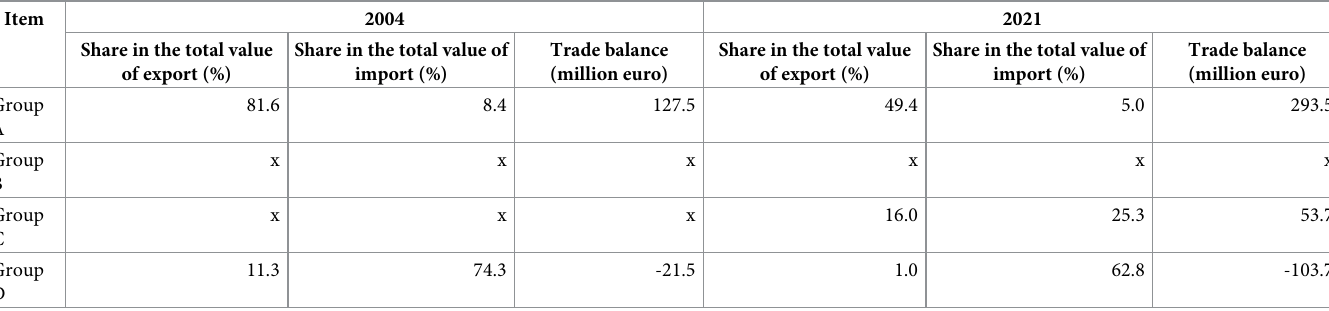
Table 8. Shares and trade balance of individual product groups resulting from Widodo’s matrix in the total value of agri-food trade between Poland and the USA. Item Share in the total value of export